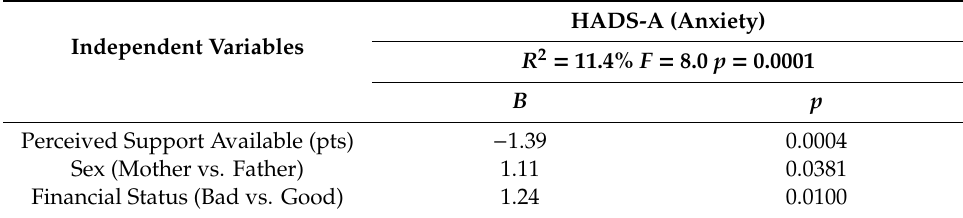
Table 6. Regression model for predicting HADS-A only in the study